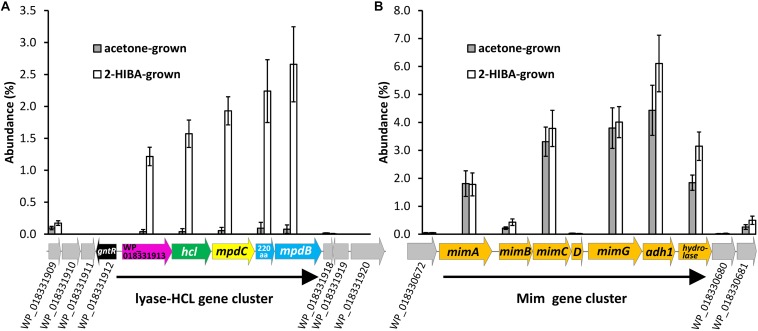
Induction of (A) the lyase-HCL and (B) the Mim gene clusters in fed-batch cultures of A. chiangmaiensis DSM 45062 grown on 2-HIBA or acetone in mineral salt medium supplemented with selenium. For comparison, abundance of proteins encoded by genes directly up- and downstream of the clusters is shown as well.